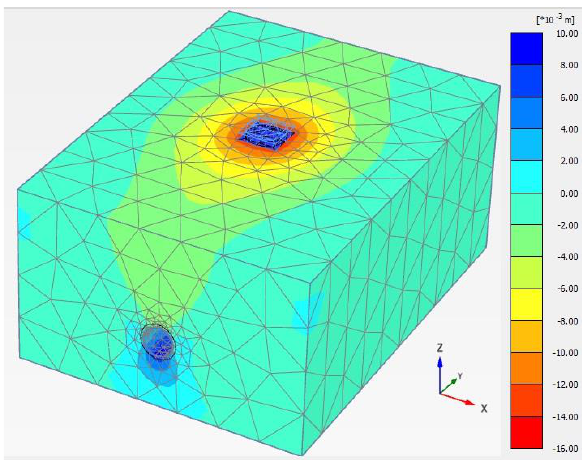
Figure 9: Soil displacement at the end of tunnel excavation Y/D= +5. (analysis VI).